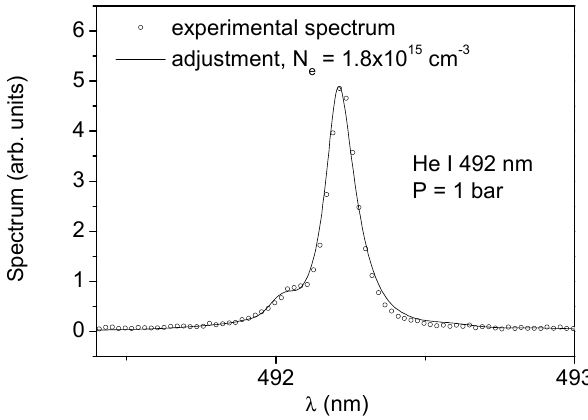
Figure 2. The plasma microfield yields an additional broadening, which can serve as a probe of the density. Here, the Stark broadening was evaluated using a computer simulation method [4].